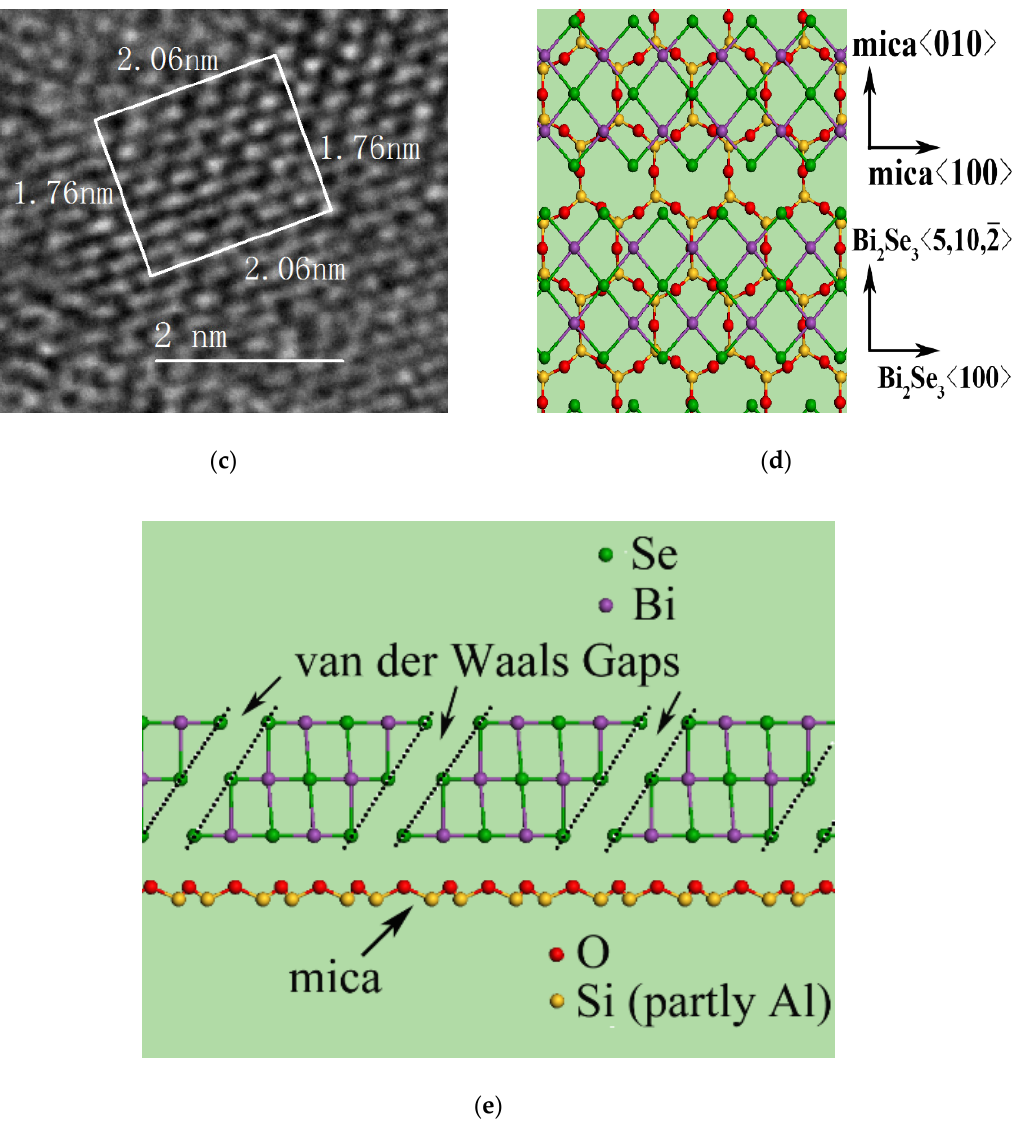
Figure 3. The TEM images and the interface models of Bi 2 Se 3 on mica. ( a , b ) show the Bi 2 Se 3 (001) // mica (001) planes; ( c )–( e ) give the Bi 2 Se 3 (015) // mica (001) planes. In the interface models, O and Si (partly Al) atoms in mica are colored respectively by red and yellow, while Bi and Se atoms in Bi 2 Se 3 are colored respectively by violet and green.